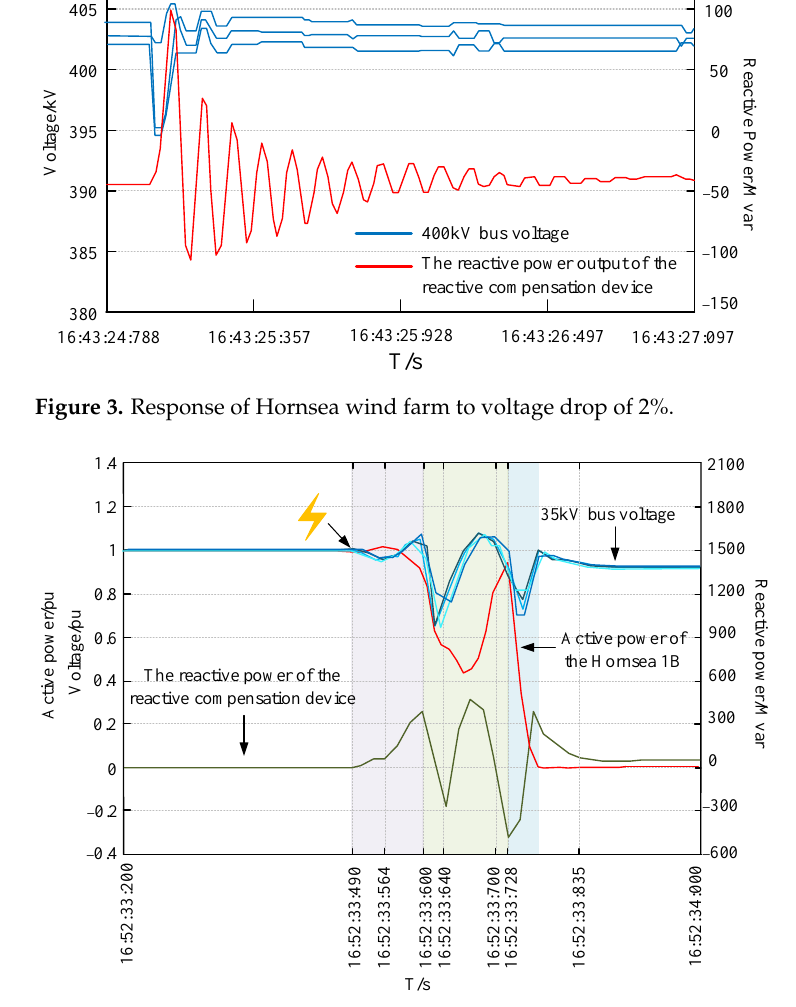
Figure 4. Development of the accident.